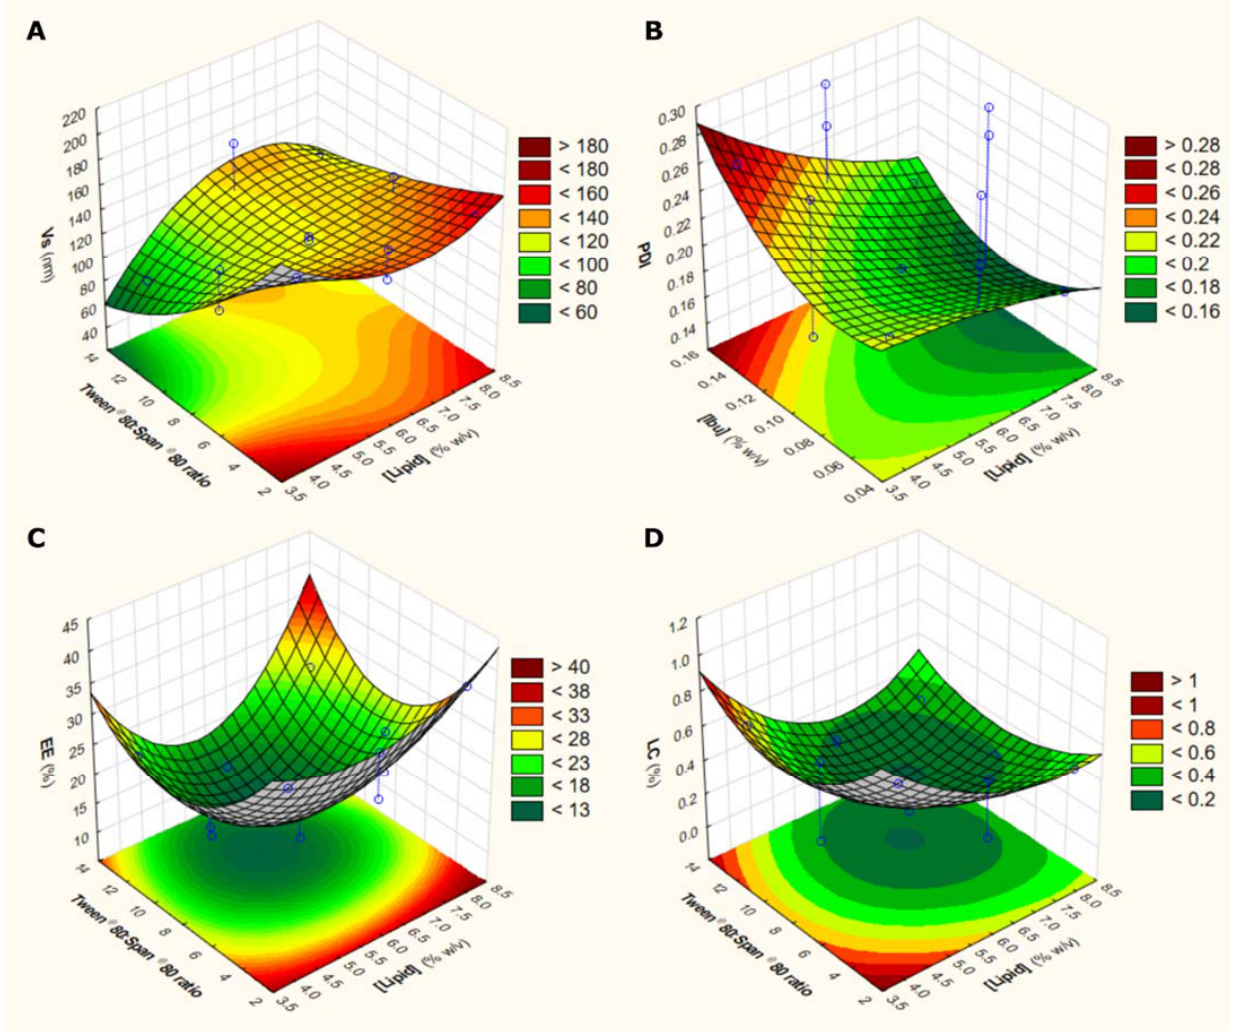
Figure 1. Response surface plots in 3D for Vs ( A ), PDI ( B ), EE ( C ), and LC ( D ). The effects of factors on each response are highlighted with various response degree levels, from dark green (lowest level) to dark red (highest level).